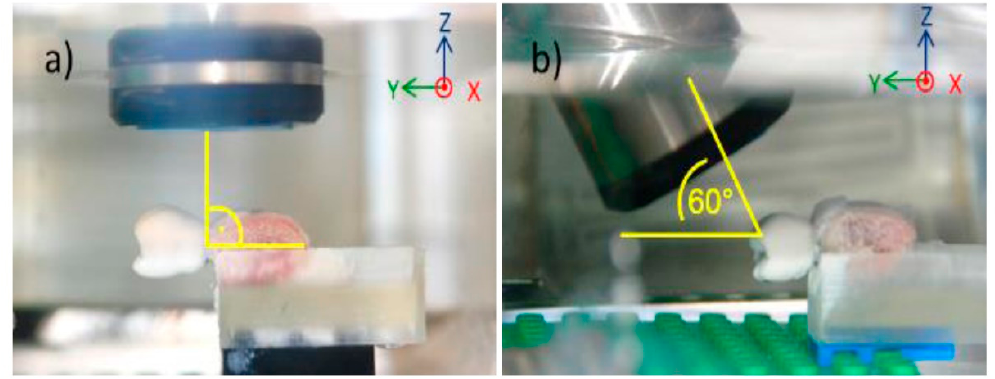
Figure 3. Scanning of porcine sample by means of ultrasound. Scanning was performed at an angle of 90 ° ( a ) and 60 ° ( b ) to the long axis of the dental implant.